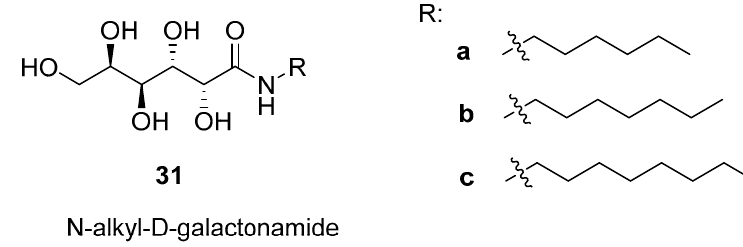
Figure 22. Galactonamide based gelators [65–67].